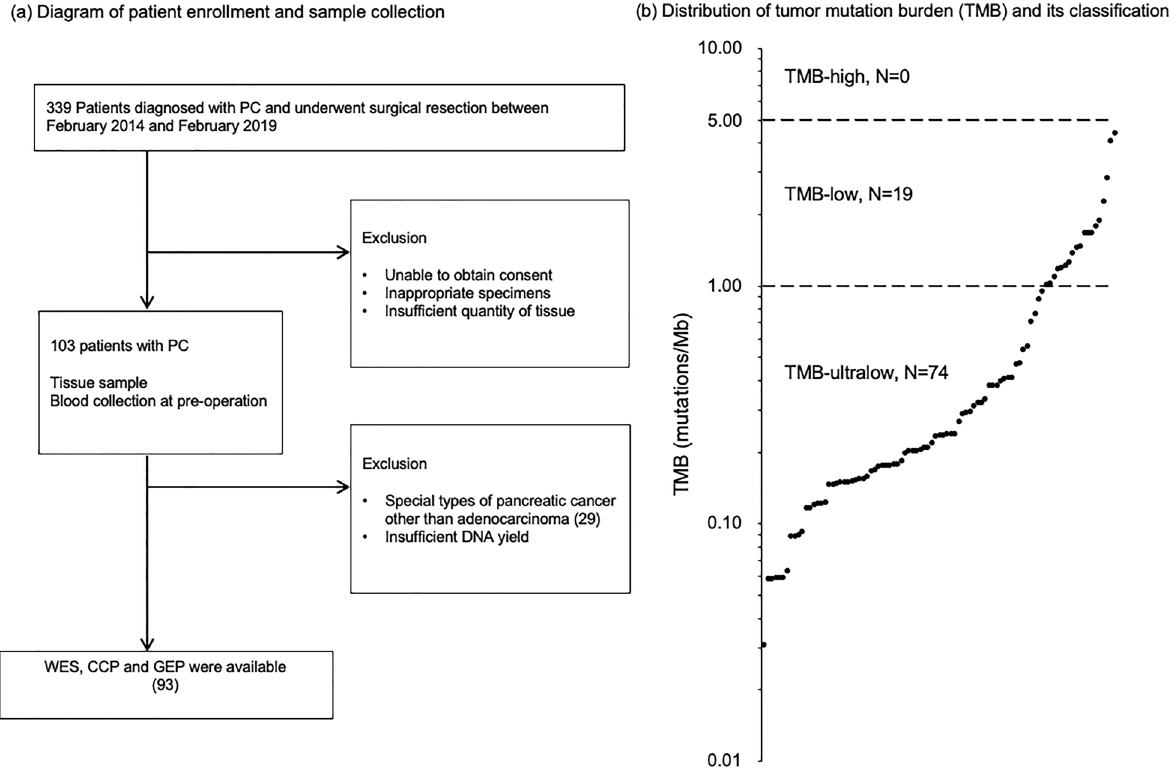
Figure 1. ( a ) Flow diagram of patient enrollment and sample collection. From January 2014 to March 2019, a total of 103 cases of PC were analyzed in Project HOPE. Tumor tissue samples were collected from resected specimens by pathologists, and all tumor tissues were pathologically diagnosed as PC. Ninety-three resected PC cases with available data for WES, CCP, and GEP were enrolled in this study. ( b ) Distribution of the TMB and its classification. The median TMB was 0.238, with an interquartile range of 0.15–0.64. No samples (0.0%) had a TMB ≥ 5.00 mutations/Mb (TMB-high). Nineteen samples (20%) had 1 to < 5 mutations/Mb, defined as